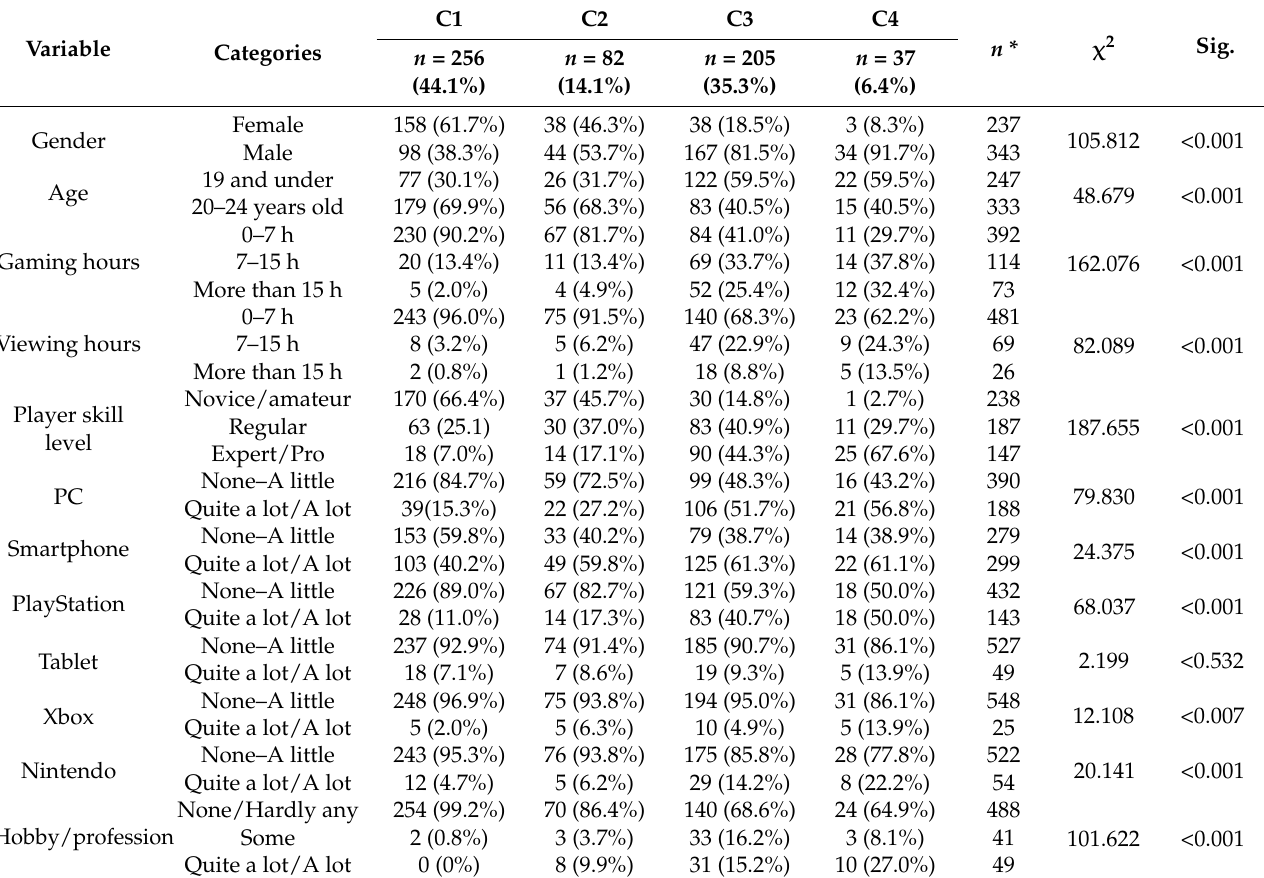
Table 4. Characterisation of components.